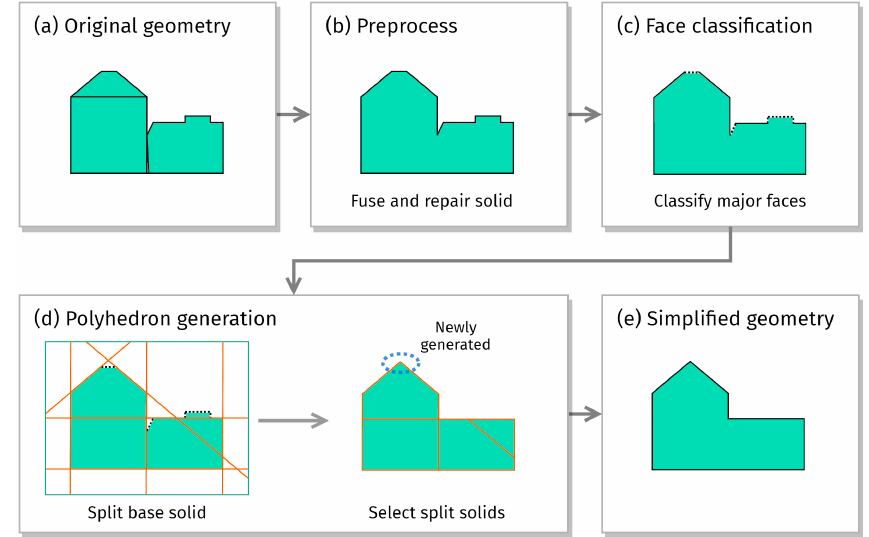
Figure 2. Automatic geometry simplification process.